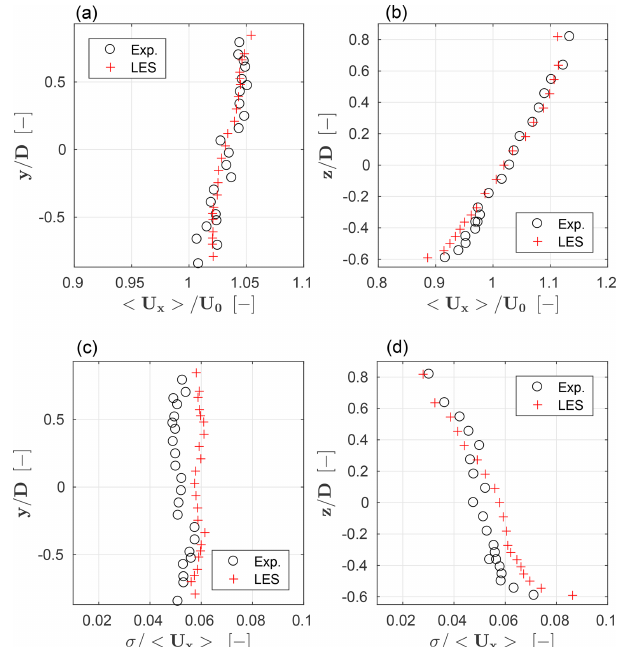
is imposed on the other surfaces, including spires, left–right walls and floor, to adjust wall shear stresses.